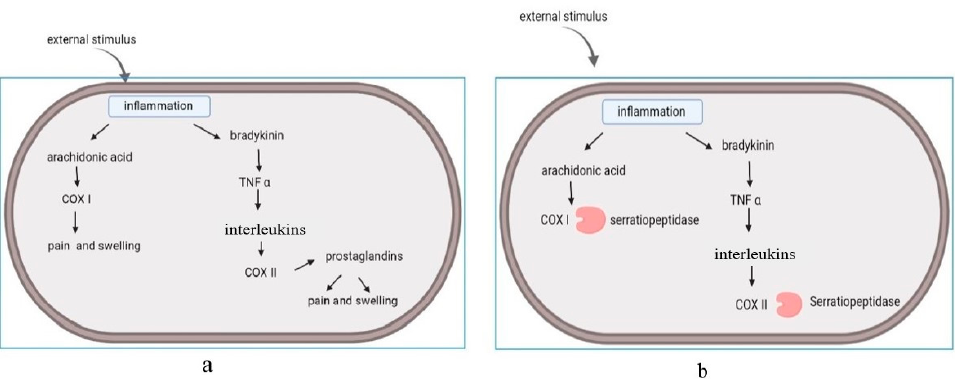
Figure 1. Arachidonic acid pathway: ( a ) release of interleukins and prostaglandins induce the pain and swelling. ( b ) Mode of action: serratiopeptidase acts on the cyclooxygenase enzyme (COX I and COX II) and suppresses the release of interleukins and prostaglandins.